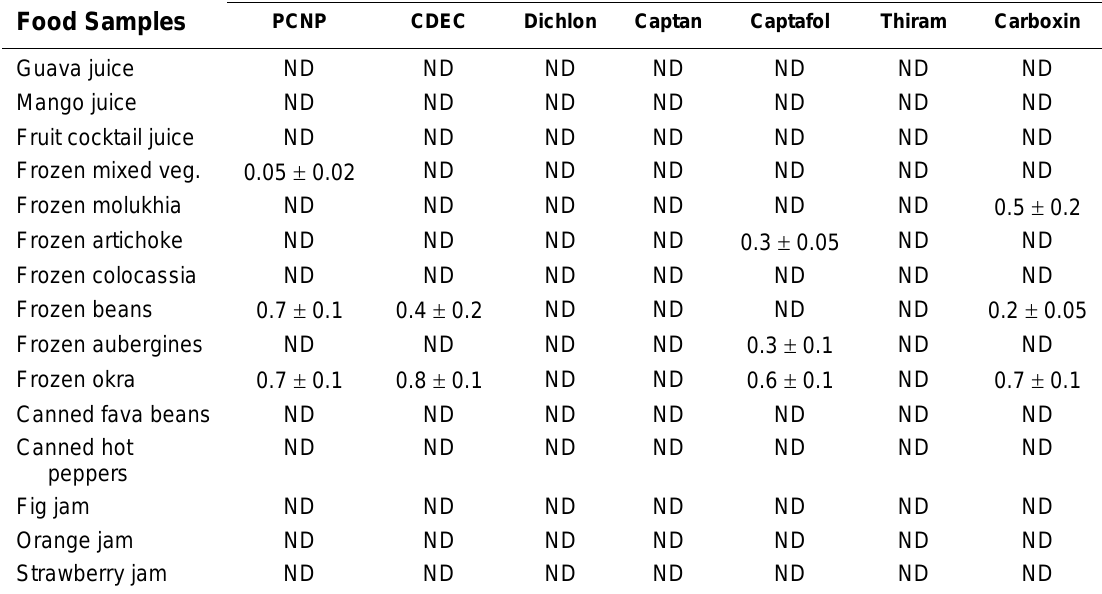
Fungicide Residues (ppm) and RSD in Food Samples Extracted by SFE and Determined by SFC/UVD at 210 nm